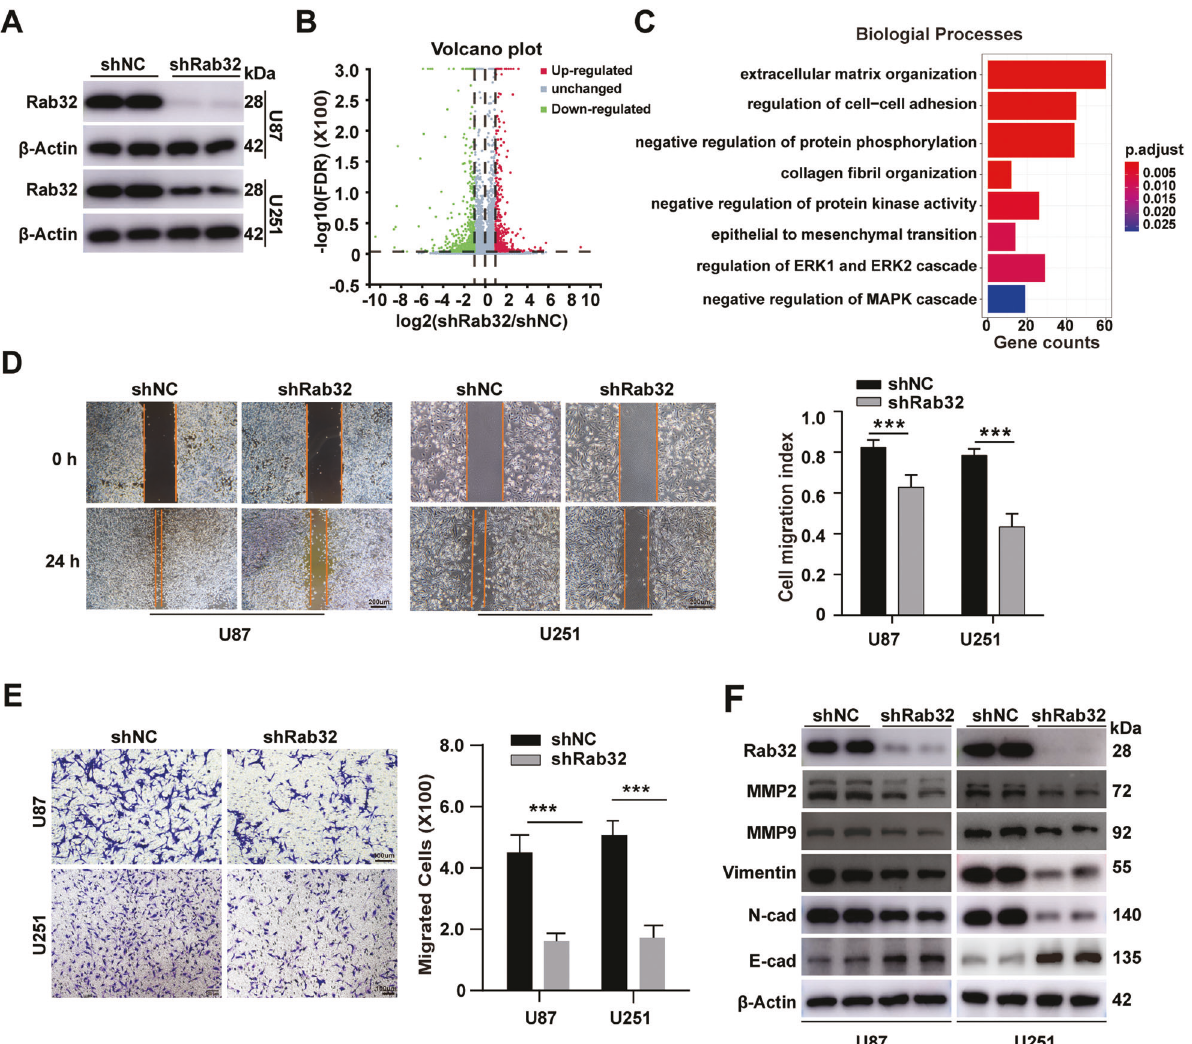
Fig. 2 Rab32 knock-down inhibits cell migration, invasion, and mesenchymal transition of glioma. A Western blot analysis of the expression of Rab32 after U87 and U251cells were infected with LV-Rab32 shRNA. β -Actin was used as a loading control. B Gene expression pro fi ling was performed in Rab32 knockdown U87 cells. Enrichment analysis of differentially expressed genes (DEGs) was presented as a volcano plot; genes with more than twofold signi fi cant changes were selected. C GO analyses were conducted to predict the potential molecular functions of Rab32. The size of the dots represents the number of genes enriched in each analysis. D A wound-healing assay was employed to analyze the migratory ability of Rab32-silenced U87 and U251 cells. Scale bar = 200 μ m. E The invasive capacity of Rab32- silenced U87 and U251 cells was analyzed using a transwell invasion assay. Representative images of cells crossing the membrane are shown. Scale bar = 100 μ m. F Western blotting analysis was performed to detect the MMP2, MMP9, Vimentin, N-cadherin, and E-cadherin expression levels. β -Actin was used as a loading control. The data are shown as the mean ± SD of three replicates. *** P < 0.001 vs. NC